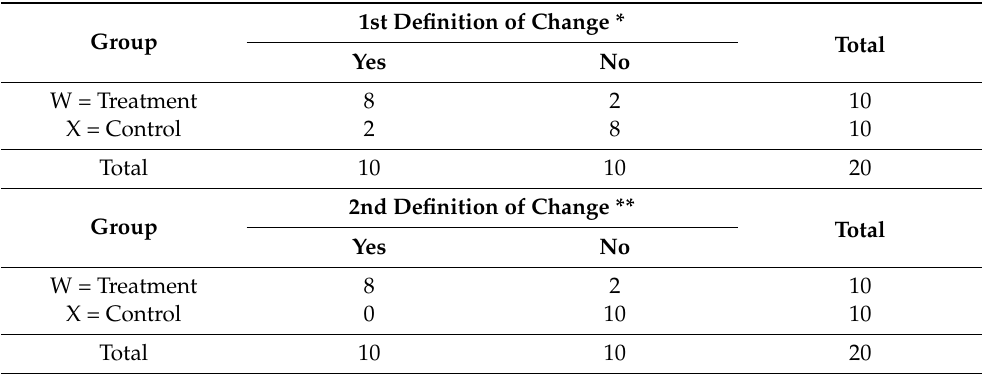
Table 3. Crosstabulation of two definitions of outcome for changes in the faecal microbiome from base- line after 12 weeks of supplementation with criteria for change and measures of effect. Significantly more treated horses showed changes compared to control horses.